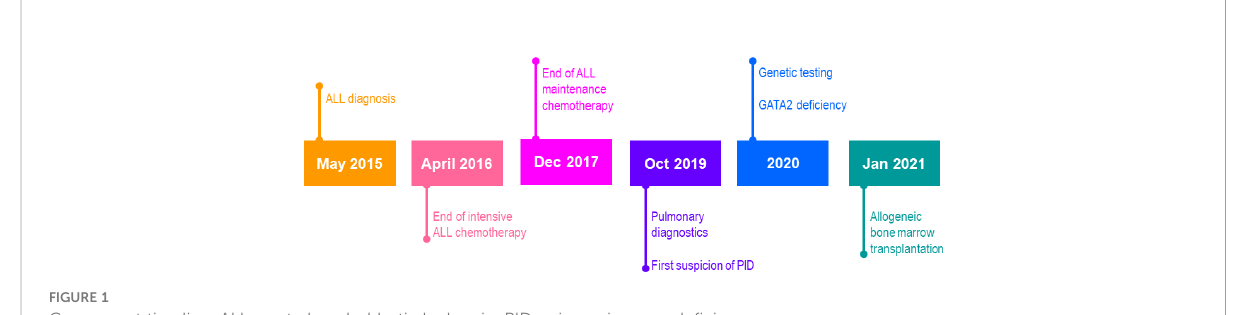
FIGURE 1 Case report timeline. ALL, acute lymphoblastic leukemia; PID, primary immunode fi